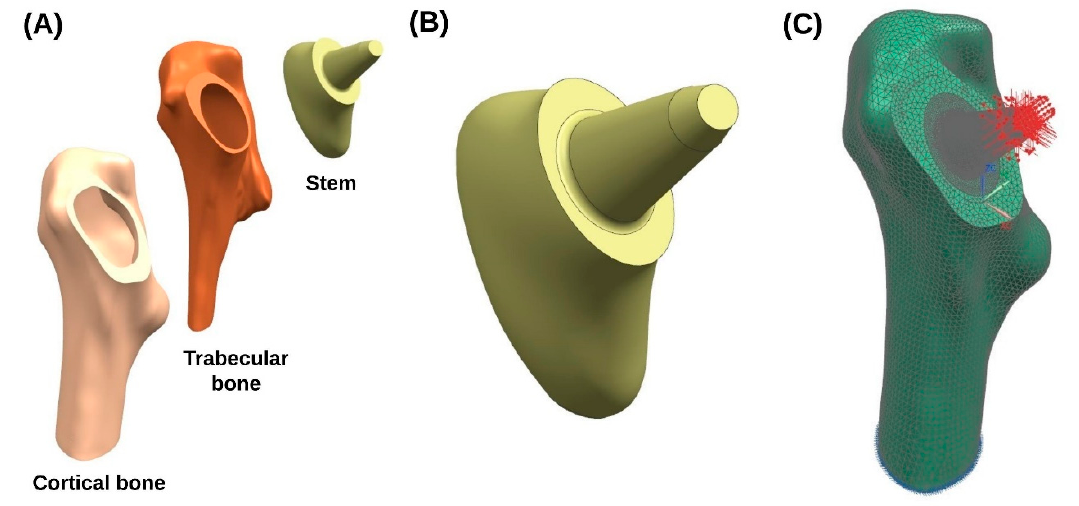
Figure 18. ( A ) Exploded view of the implanted femur. ( B ) Short stem. ( C ) Boundary conditions.